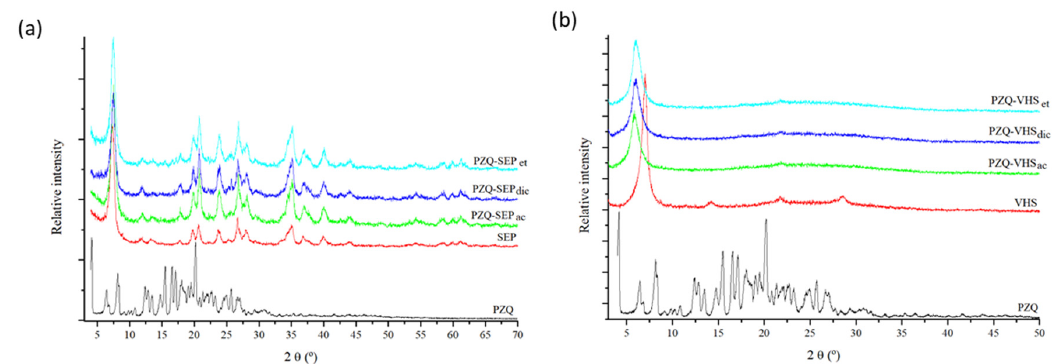
Figure 1. XRPD patterns of the studied samples with sepiolite ( a ) and montmorillonite ( b ).